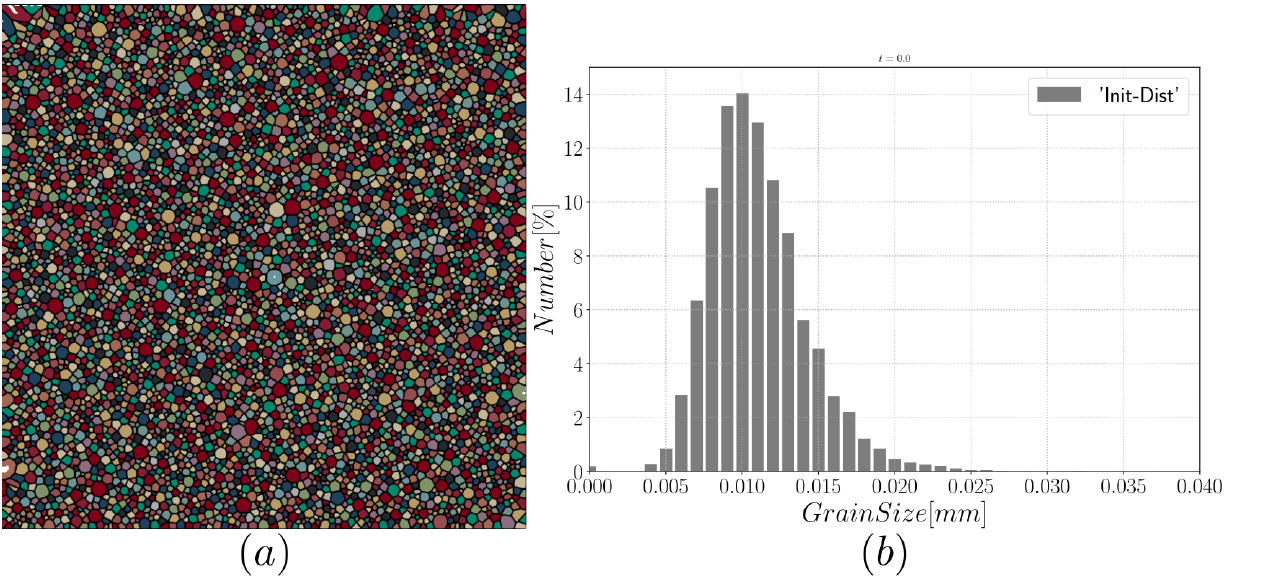
Figure 11. Initial microstructure ( a ) with 5000 grains and the grain size distribution, in number ( b ). Figure 12 shows the orientation field using the vector magnitude O G = where ( ϕ 1 , φ , ϕ 2 ) are the three Euler angles. The Euler angles defining the crystallographic orientations generated in this case are generated randomly, leading to a Mackenzie-like disorientation distribution function [57]. As the Read–Shockley model is used to define γ , the GB energy is concentrated at high values, as illustrated in Figure 13.